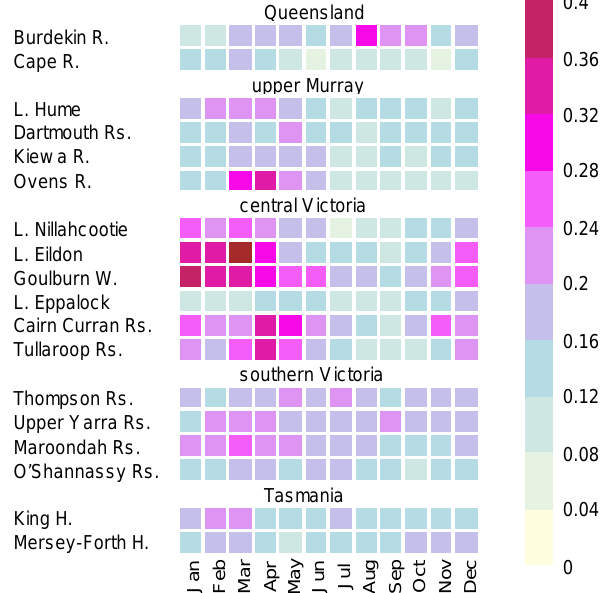
Fig. 3. Performance of WAPABA in all 18 catchments in terms of RMSEP values calculated for each